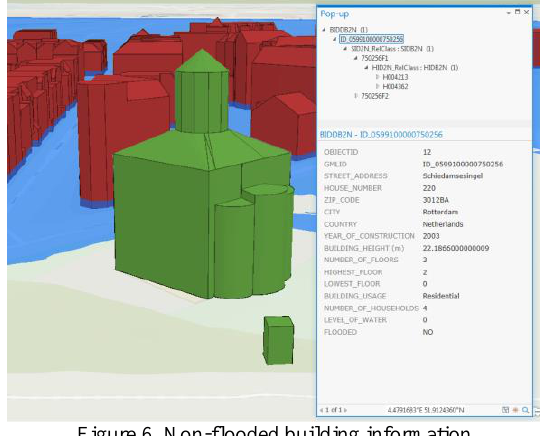
Figure 6. Non-flooded building information